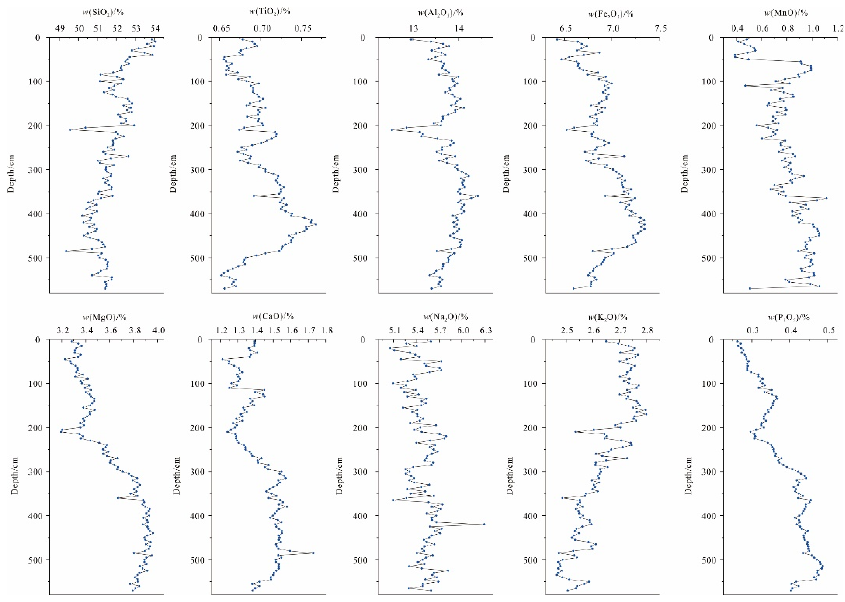
Figure 4. Profile distribution of major elements along the core.